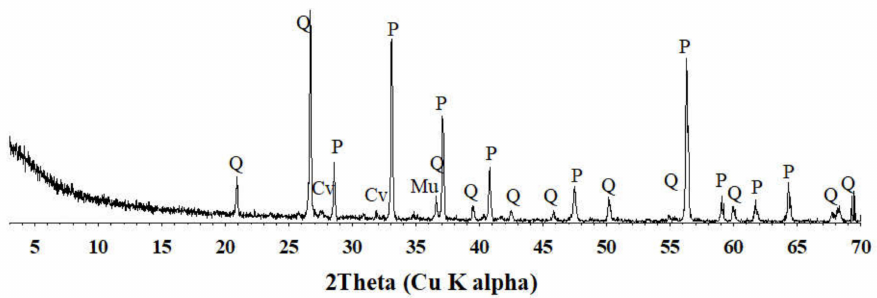
Figure 1. XRD pattern of gold raw concentrate. Cv, covellite; P, pyrite; Q, quartz; and Mu, muscovite. Table 1. Chemical composition of gold concentrate from Golden Sun mine (unit: mg/kg). Elements As